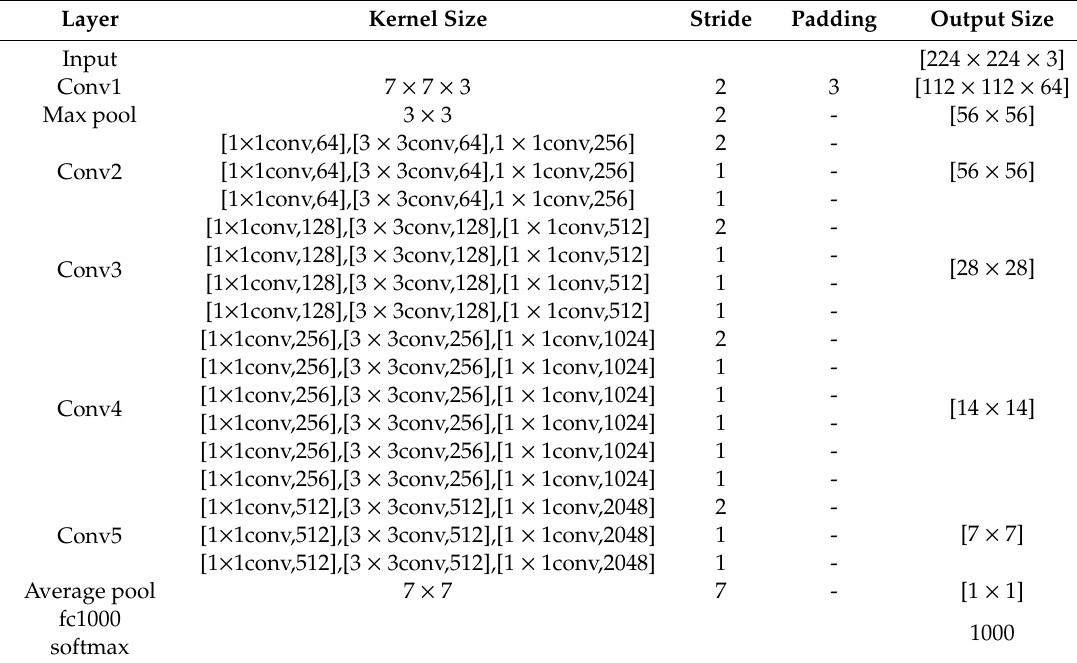
Table 2. Details of ResNet-50